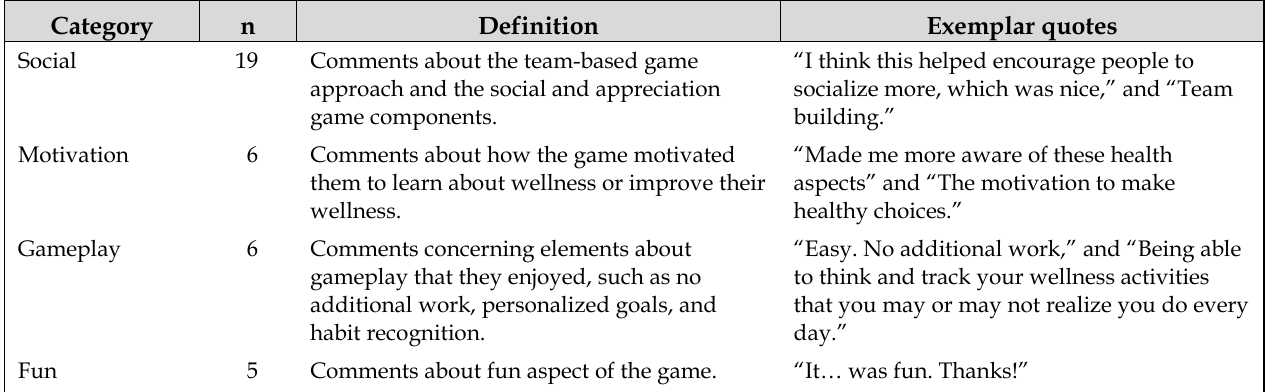
Table 5 Qualitative categories for “What did you enjoy most about the game?” Category